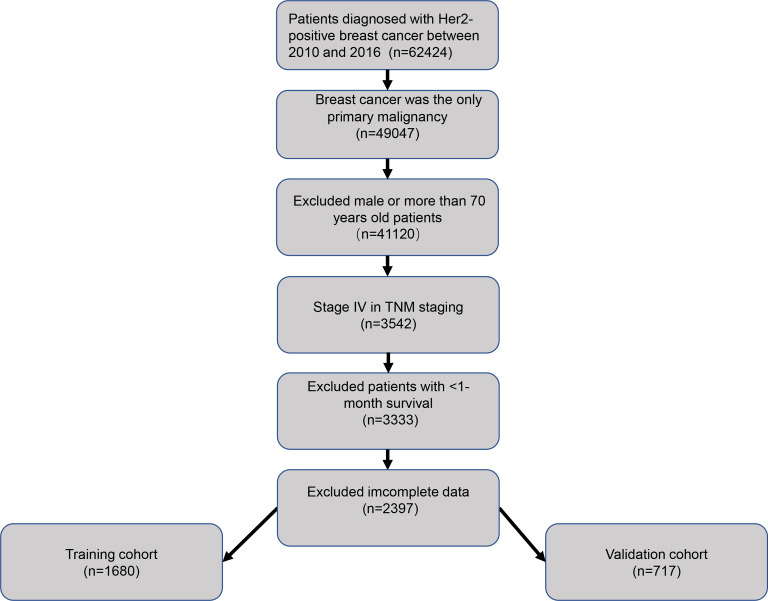
The flowchart of data extraction; Her 2, human epidermal growth factor receptor 2.